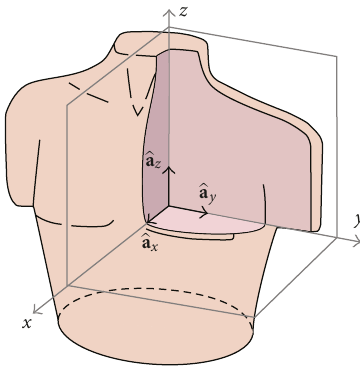
Figure 1: The three body axes, adapted from